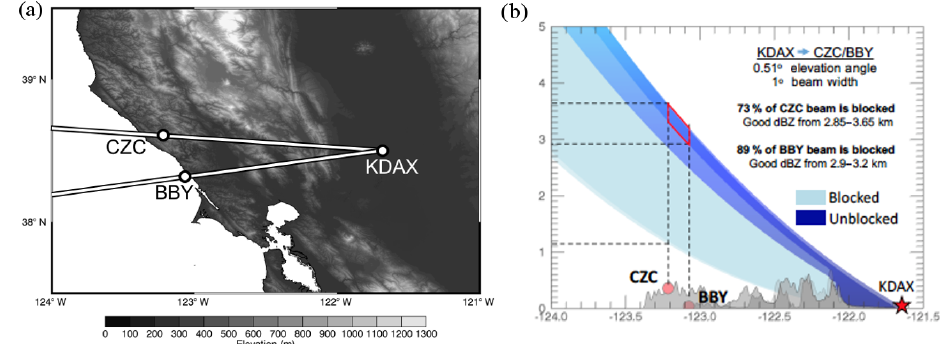
Figure 2. (a) Plan view of region surrounding the study area with KDAX, BBY and CZC labeled. Beams show path of radar from KDAX to each site (BBY, CZC). White shading indicates relative terrain height (ma . m . s . l . ). (b) Height vs. longitude cross section with KDAX 0.51 ◦ elevation scan beam blocked (light blue), unblocked over CZC (medium blue) and unblocked over BBY (dark blue) layers. Red trapezoid indicates the volume from BBY azimuths that are unblocked and share the altitudes of the CZC unblocked layer. Location of BBY (CZC) indicated by red dot at respective longitude and height. Terrain profiles along BBY (CZC) azimuths also indicated in gray